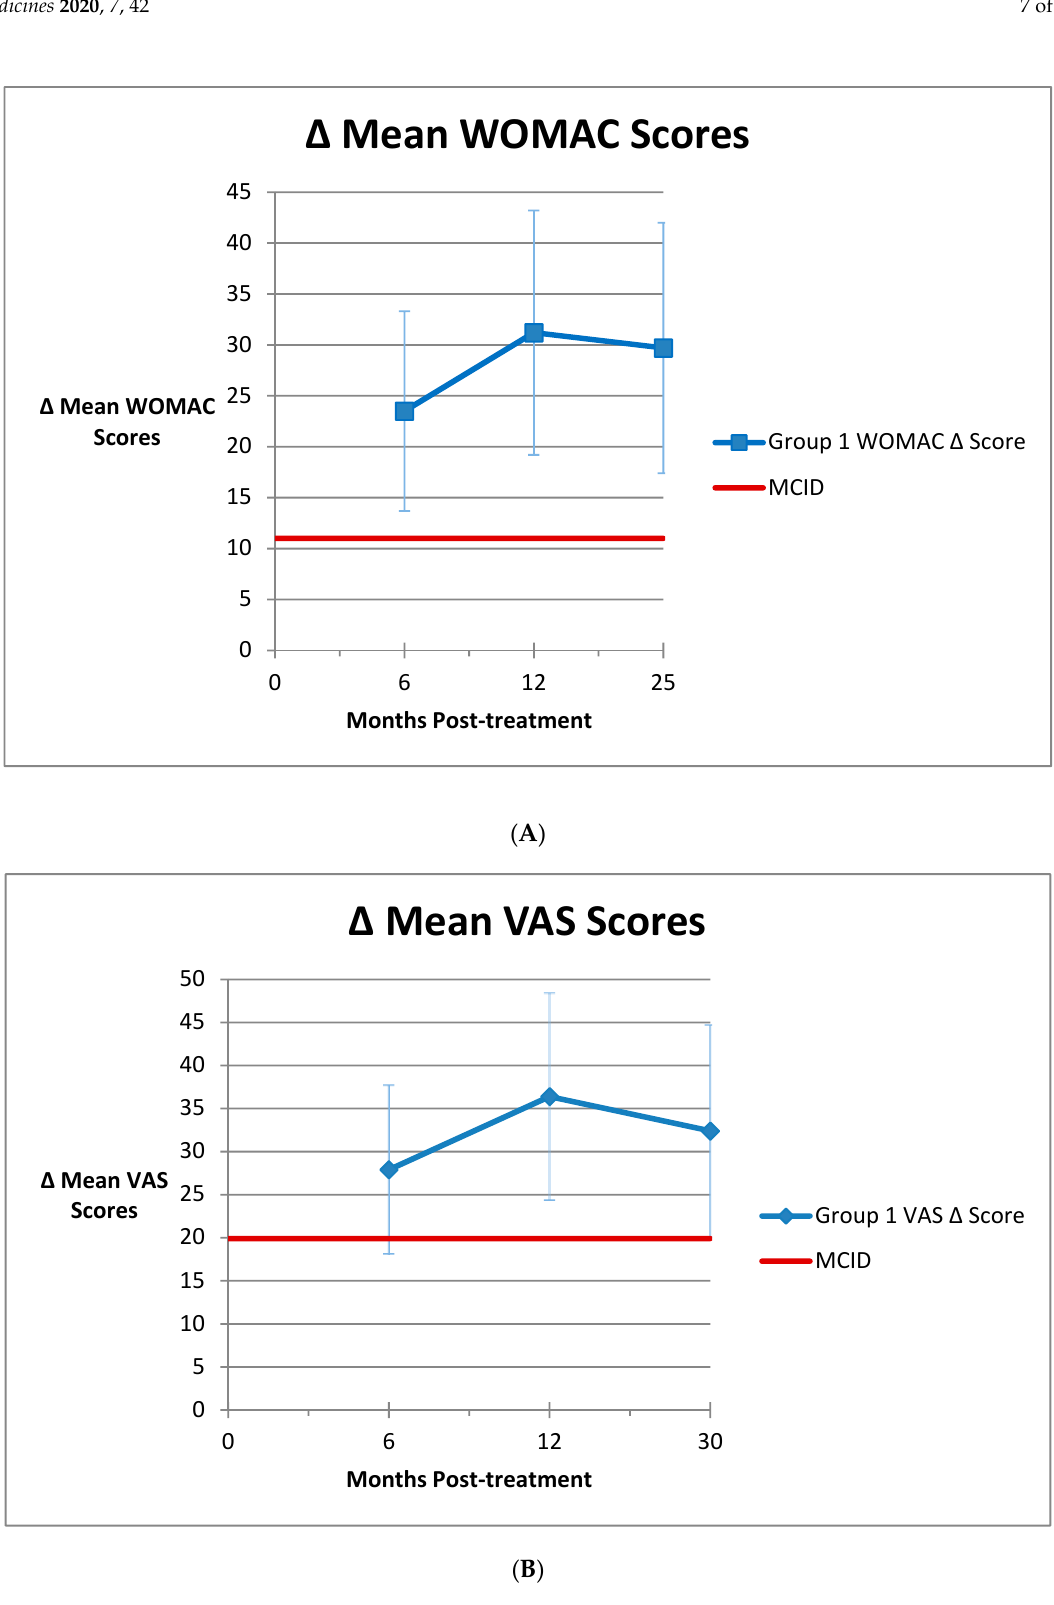
Figure 2. ( A ) Intermediate and long-term mean improvement in WOMAC scores starting from 6 months post-treatment. Vertical bars indicate 95% confidence interval. ( B ) Intermediate and long-term mean improvement in VAS scores starting from 6 months post-treatment. Vertical bars indicate 95% confidence interval.